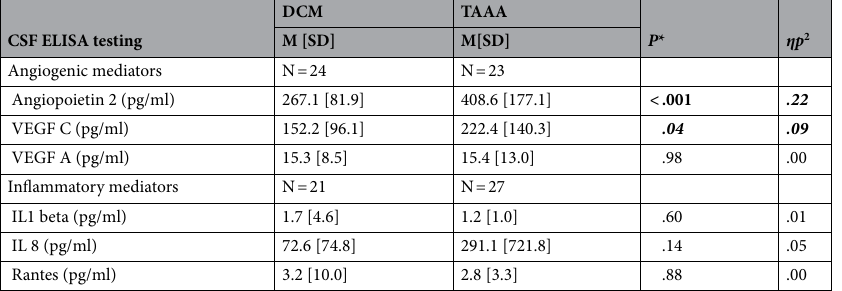
Table 3. CSF ELISA testing of patients (DCM) and controls (TAAA). CSF cerebrospinal fluid, DCM degenerative cervical myelopathy, pg/ml picogram per milliliter, M mean , SD standard deviation, TAAA thoracic-abdominal aortic aneurysm. * p values reflect the univariate post-hoc between group tests revealed by the MANOVAs; ηp 2 = partial eta squared effect size. Bold values indicate significance level of p < .05.